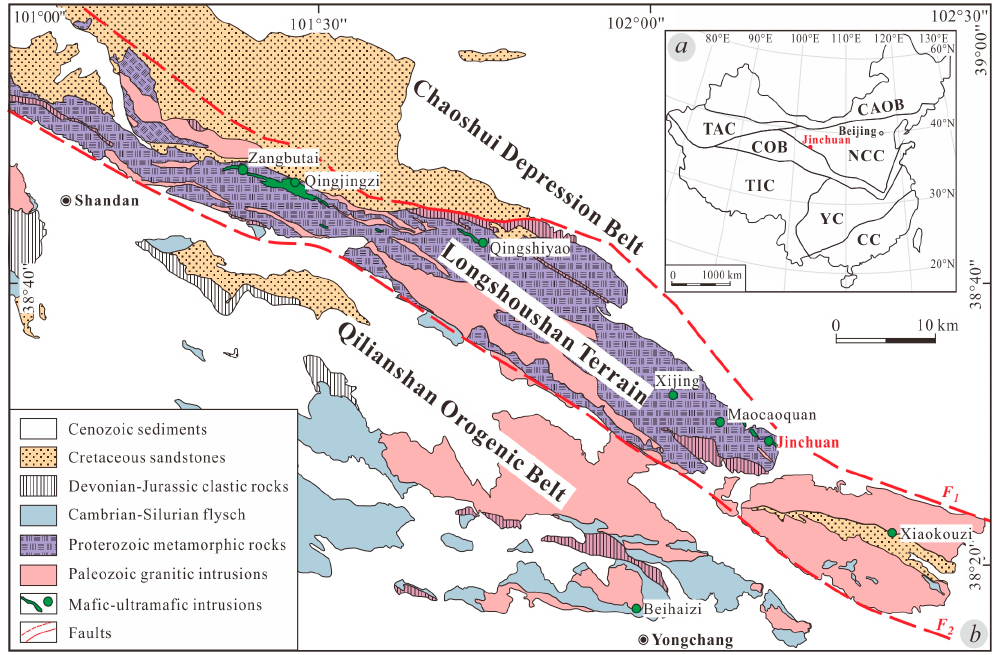
Figure 1. ( a ) The location of the Jinchuan Ni-Cu-PGE deposit in China (modified after [32]). ( b ) Simplified geological map of the Longshoushan Terrane (modified after [35]). Abbreviations: CAOB, Central Asian Orogenic Belt; CC, Cathaysia Craton; COB, Central Orogenic Belt; NCC, North China Craton; TAC, Tarim Craton; TIC, Tibet Craton; YC, Yangtze Craton.